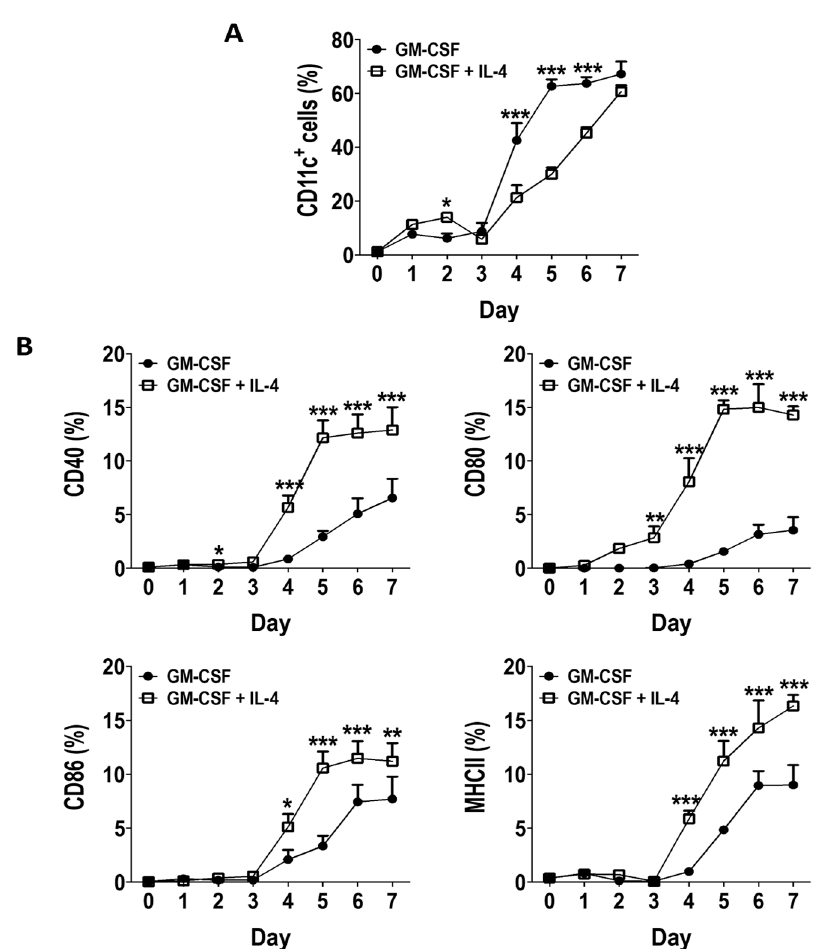
Figure 1. GM-CSF induces generation of DCs with lower activation marker expression in BM cultures compared to GM-CSF + IL-4. DCs (CD11c + cells) generated from murine BM with GM-CSF (10 ng / mL) (black circles) or GM-CSF (10 ng / mL) + IL-4 (5 ng / mL) (white squares) from days 1–7 were evaluated for ( A ) the percentage of DCs generated and ( B ) the expression of CD40, CD80, CD86 and MHCII on the DCs. Results shown are from three mice, two-way ANOVA was used to compare both cultures at each time-point. Results displayed as mean +/ − SD. * p < 0.05, ** p < 0.01, *** p < 0.001.